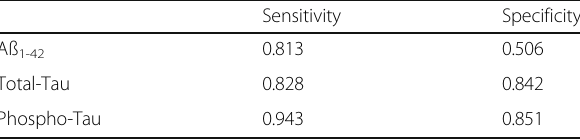
Table 18 Differentiation of NPH versus other dementias and